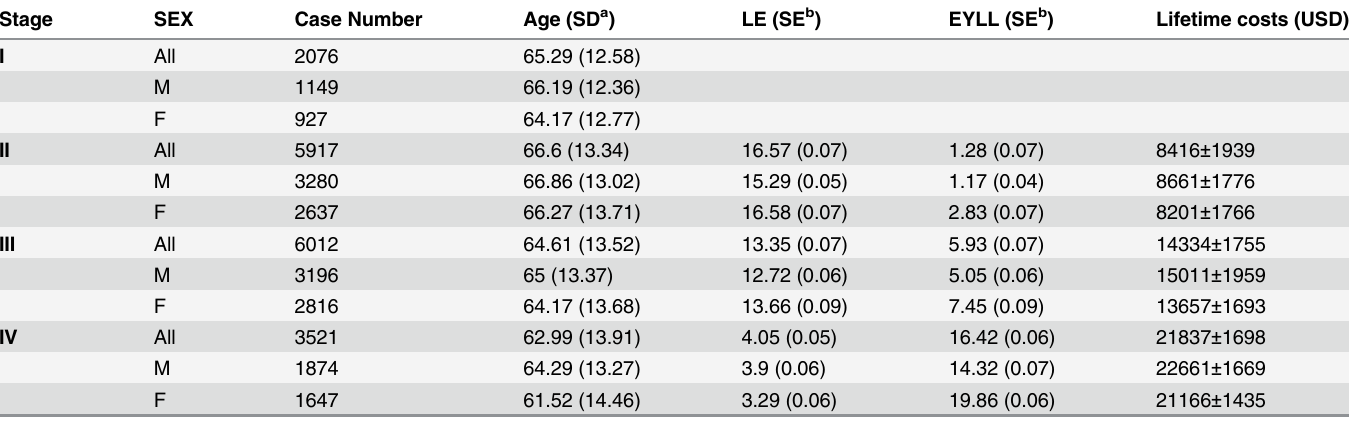
Table 2. The life expectancy (LE), expected years of life lost (EYLL), and lifetime costs of colon adenocarcinoma by stage and gender. Stage